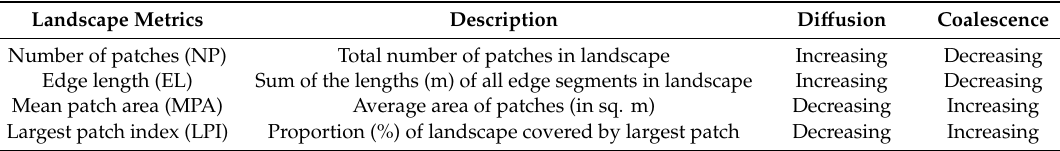
Table 2. Landscape metrics used in this study (from [37],